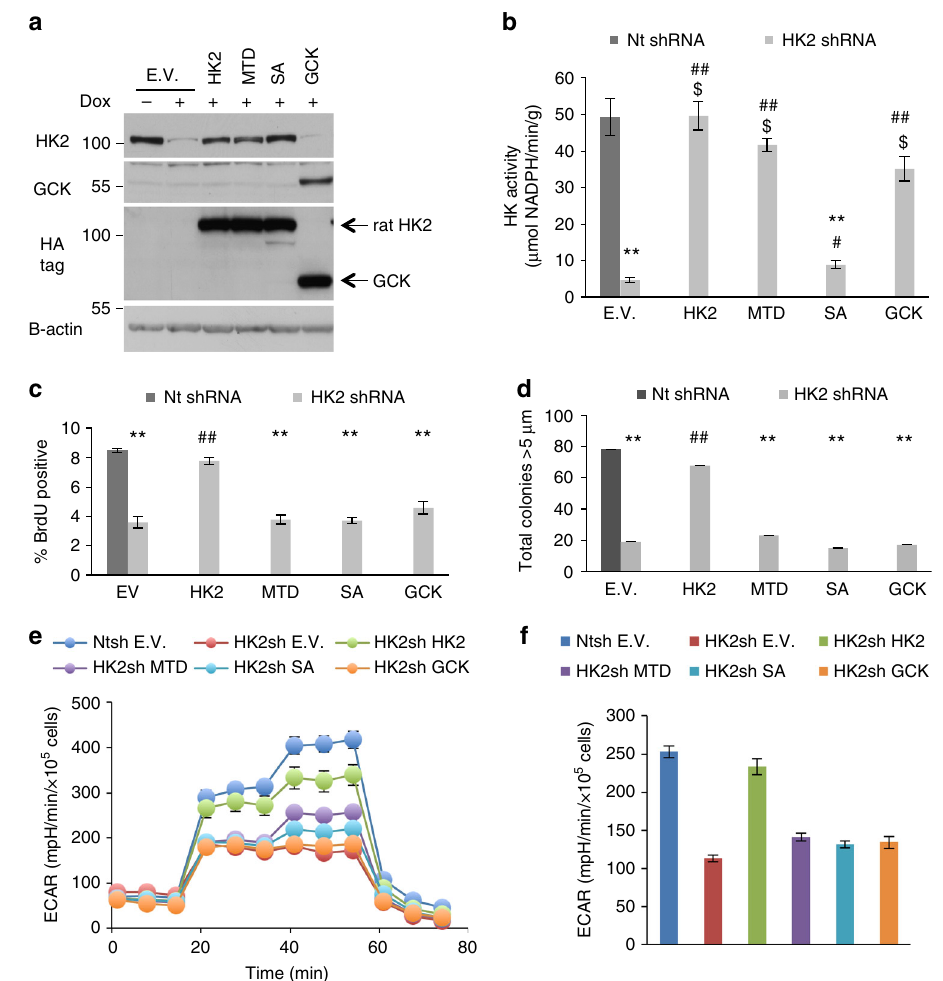
Fig. 3 Replacement of endogenous HK2 with WT and HK2 mutants, and GCK. a Immunoblot analysis of engineered Huh7 cell lines for both endogenous HK2 KD and overexpression of different hexokinase isoforms. HA-tagged WT rat HK2 and mutants, resistant to silencing by human shRNA, and HA-tagged GCK were stably expressed in Huh7 cells expressing Dox-inducible HK2 shRNA. EV — empty vector, MTD — mitochondrial binding de fi cient mutant, SA — kinase dead mutant. b Analysis of in vitro hexokinase activity in the engineered stable cell lines. c Relative BrdU incorporation assay in the engineered cell lines. d AIG analysis in engineered cell lines. e , f Seahorse metabolic analysis (ECAR) of control cells (shNt EV), HK2 KD cells (shHK2 EV), shHK2 EV cells expressing WT HK2 (shHK2 HK2), expressing mitochondrial binding de fi cient mutant (shHK2 MTD), or glucokinase (shHK2 GCK). The cells were exposed to Dox for 3 days prior to analysis. The results are presented as the mean ± SEM; ** p < 0.01 vs. Nt EV $ p > 0.07 vs. EV — Dox; # p < 0.05, and ## p < 0.01 vs. EV + Dox, by Student ’ s t-test. Experiments were performed at least twice in